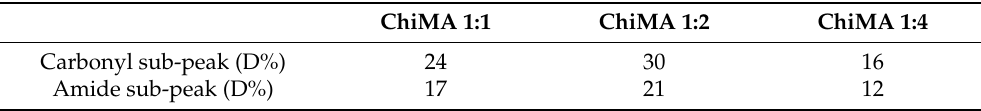
Table 2. Semi-quantification of sub-peak component variation (%) for carbonyl and amide groups in ChiMA samples with respect to the pristine chitosan. ChiMA